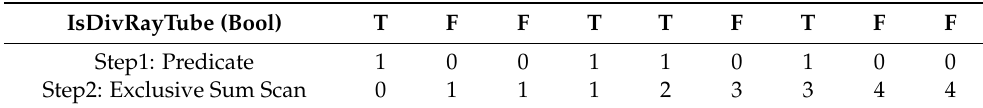
Figure 4. The procedure of multi-blocks Scan algorithm. Table 1. Compact